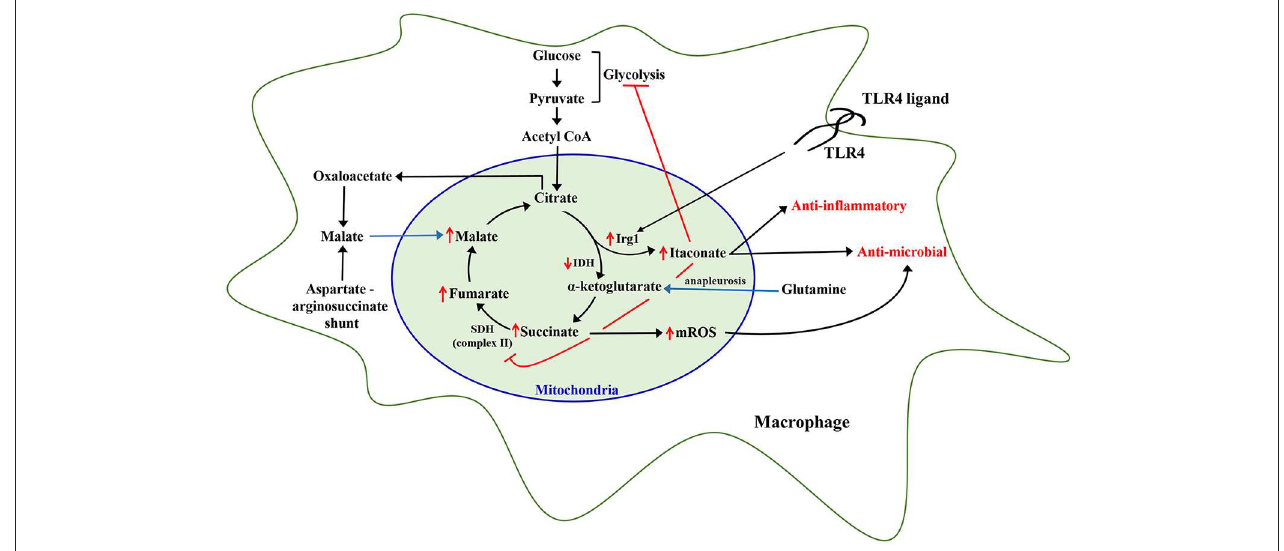
FIGURE 1 | Metabolic reprogramming of leukocytes. Inflammatory stimulation of leukocytes, specifically monocytes and macrophages, with Toll-like receptor 4 (TLR4) ligands like lipopolysaccharide, has been shown to rewire mitochondrial metabolic pathways including upregulation of immunoresponsive gene 1 (Irg1) leading to increased itaconate generation, and increased accumulation of other TCA cycle metabolites including succinate, fumarate, malate, and citrate which continue to be replenished via additional pathways including glutamine anapleurosis and aspartate-arginosuccinate shunt. Itaconate produced by Irg1 inhibits succinate dehydrogenase, which causes an increase in mitochondrial reactive oxygen species (mROS). Itaconate and mROS augment antimicrobial capacity of